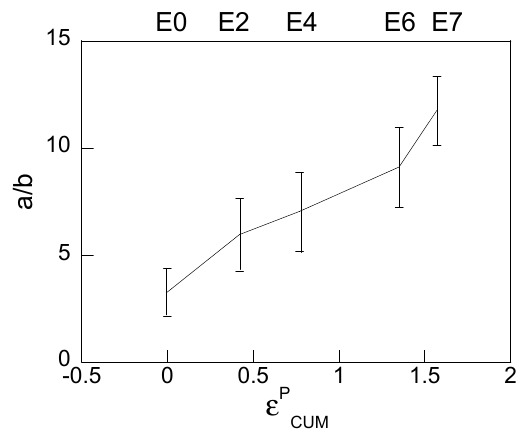
Figure 9. Shape factor evolution for soft -type inclusions.